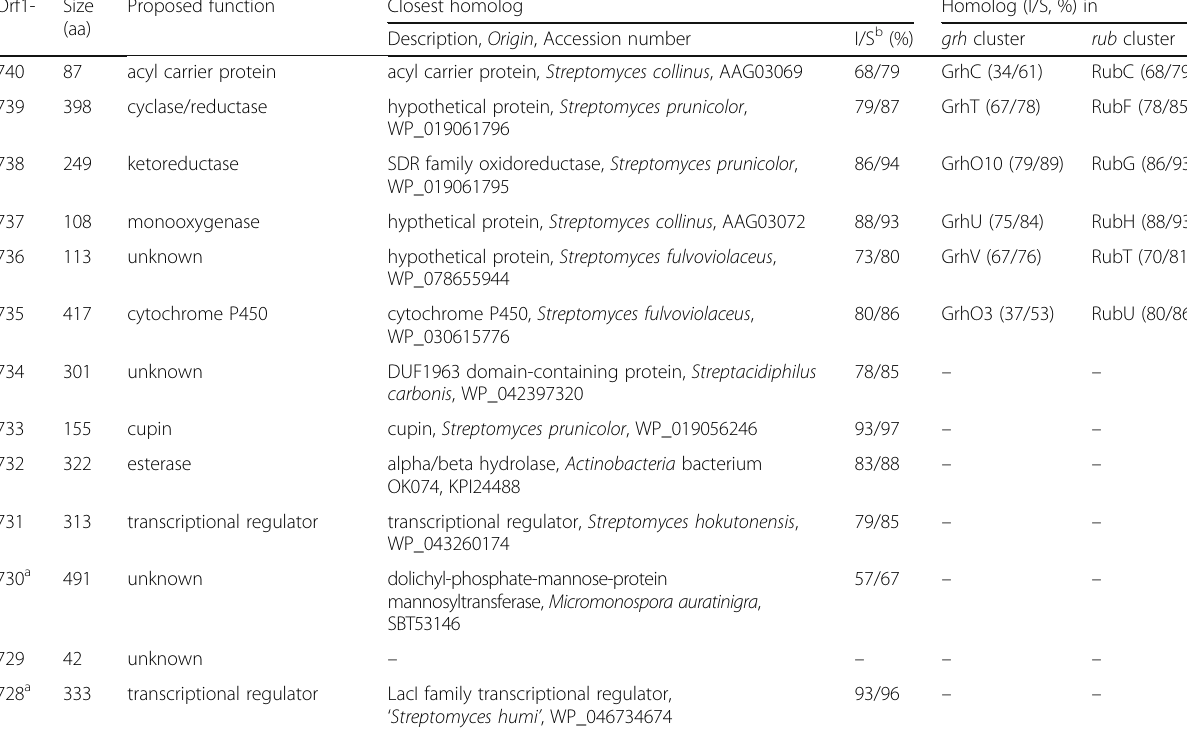
Table 5 Putative hyaluromycin biosynthetic gene cluster and the neighboring genes (Continued)